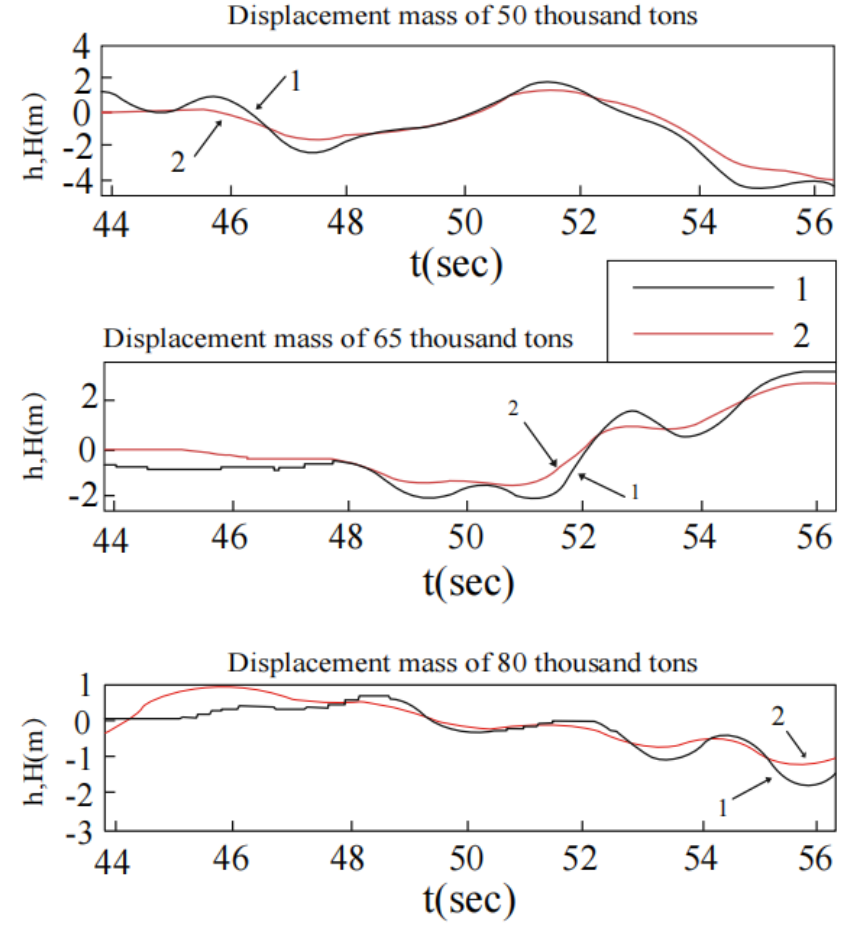
Figure 14. The response curves of carrier aircraft tracking the vertical motion of ideal landing point under different ship sizes.